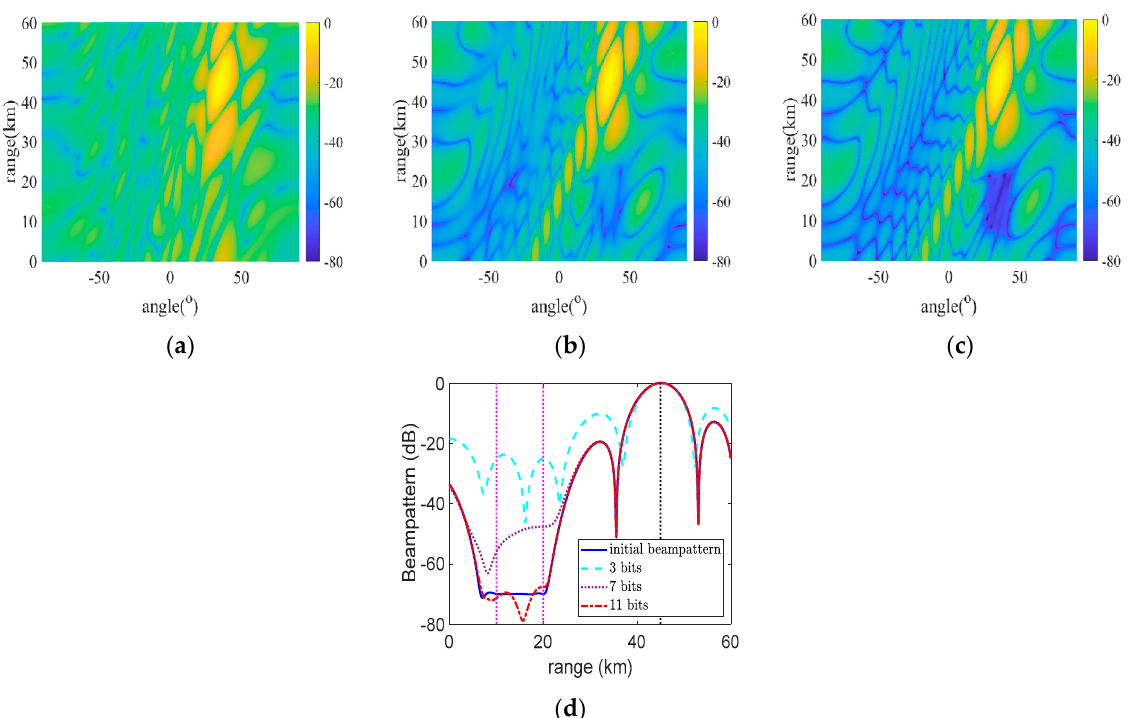
Figure 11. The constant modulus decomposition CNBC beampattern on different quantization bits: ( a ) 3 bits, ( b ) 7 bits, ( c ) 11 bits, ( d ) cross–section of different quantization at target angle.